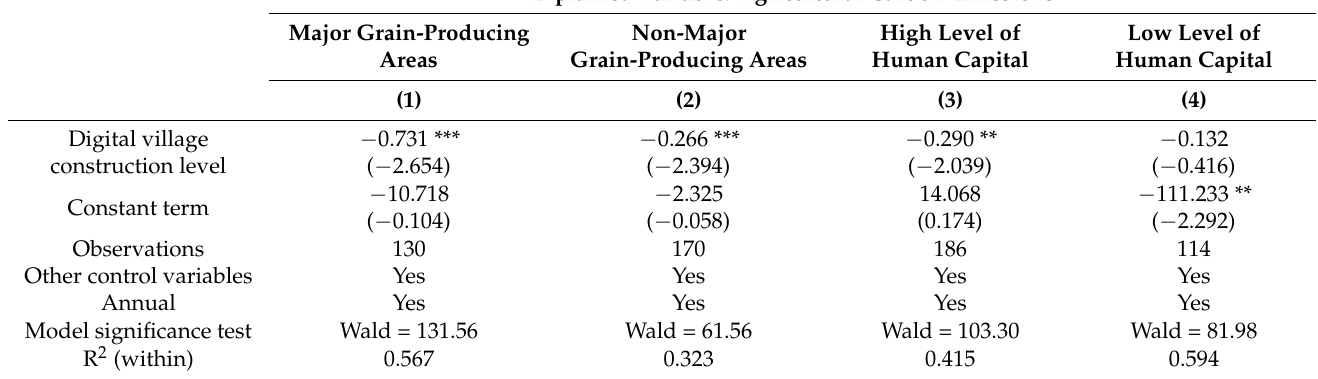
Table 10. Heterogeneity test